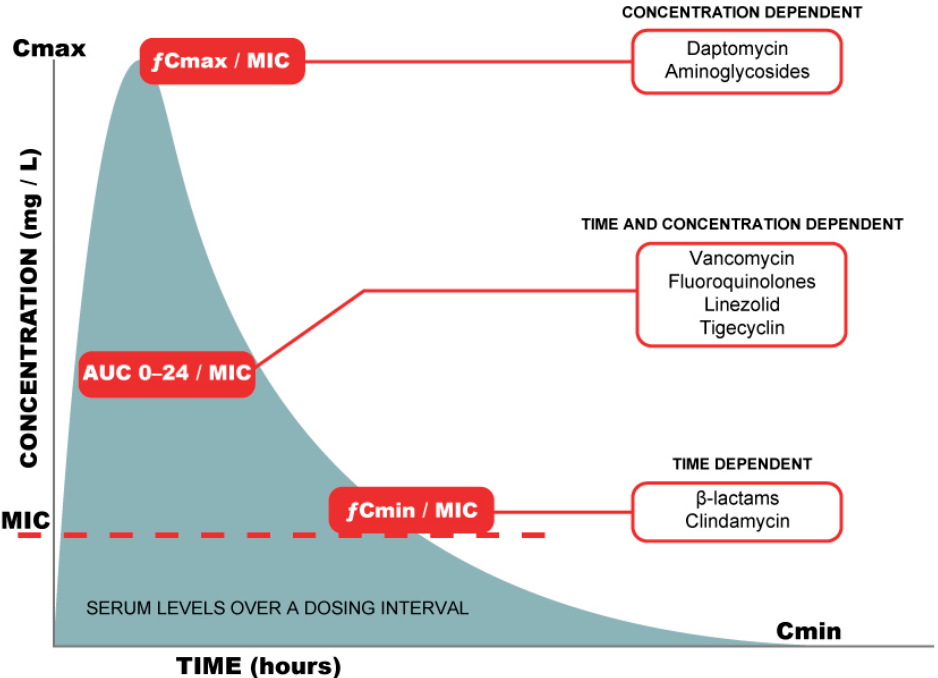
Figure 2. Pharmacokinetic targets for main antibiotic classes. Cmax = maximum serum concentration during a dosing interval, Cmin = trough (minimum) serum concentration over a dosing interval, MIC = minimum inhibitory concentration of the pathogen for the considered antibiotic, fCmax/MIC = ratio of free peak plasma concentration to MIC, fAUC/MIC = ratio of free unbound drug concentration area under the curve to MIC, fT > MIC = free unbound drug concentration time above the MIC.